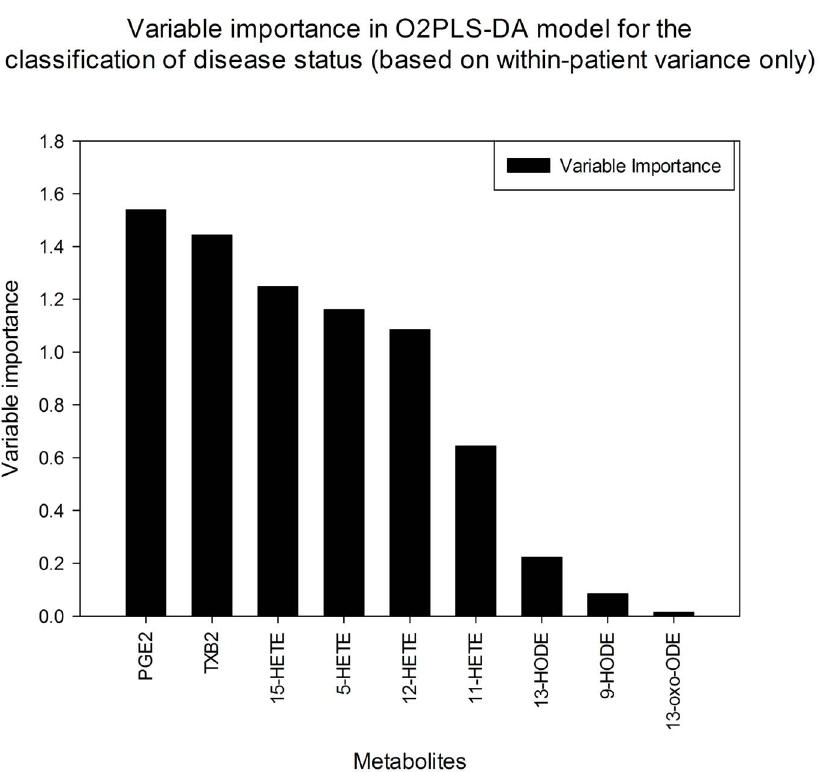
Figure 5. Variable importance plot in O2PLS-DA analysis demonstrates relative contribution of lipid mediators to separation between inflamed and non-inflamed mucosa. (Fig. 4).